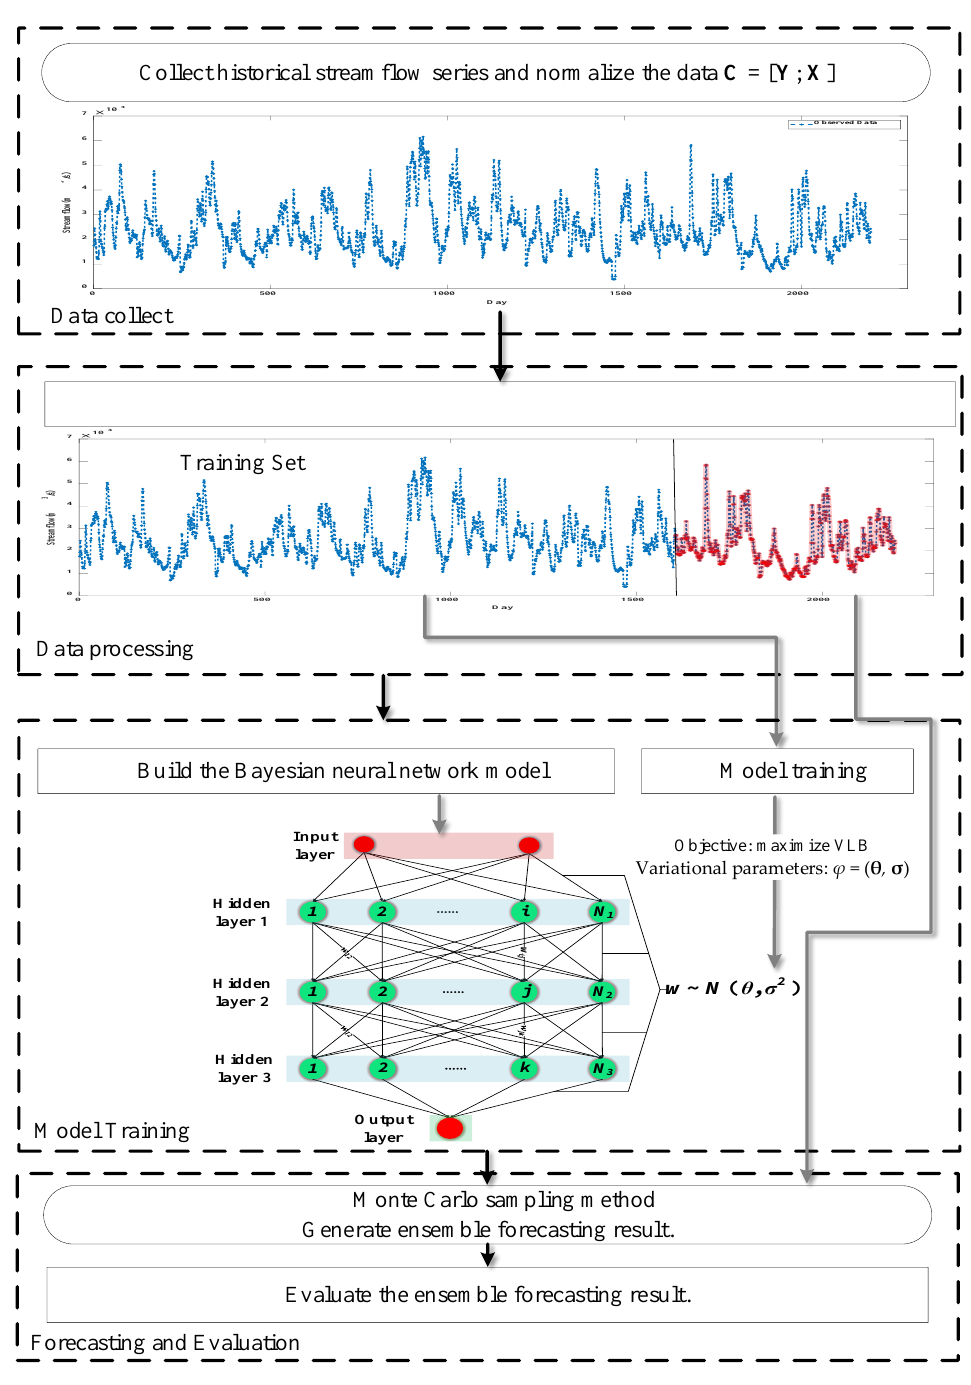
Figure 2. The flowchart of VBNN.